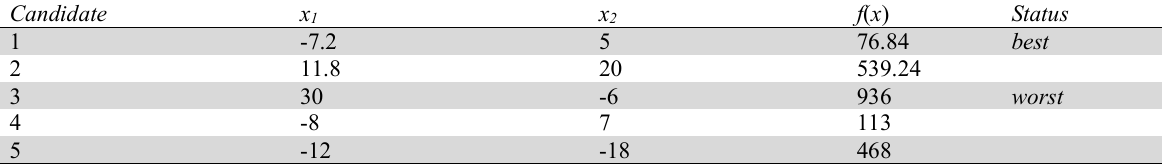
Updated values of the variables and the objective function based on fitness comparison at the end of first iteration (Rao-1)